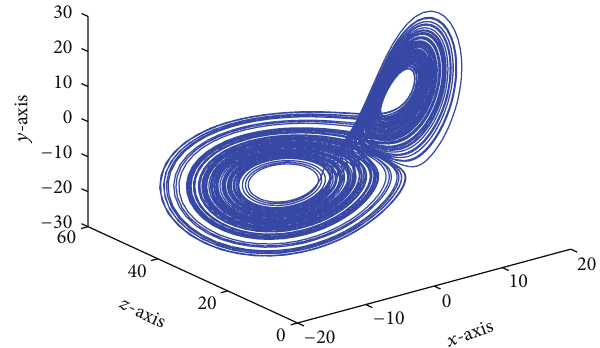
Figure 1: Trajectories of the synchronous